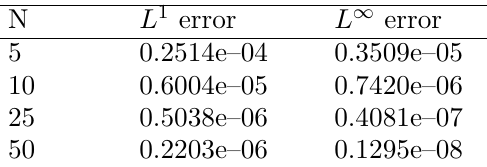
Table 1. L 1 and L ∞ convergence re- sults at x = 0 . 2.